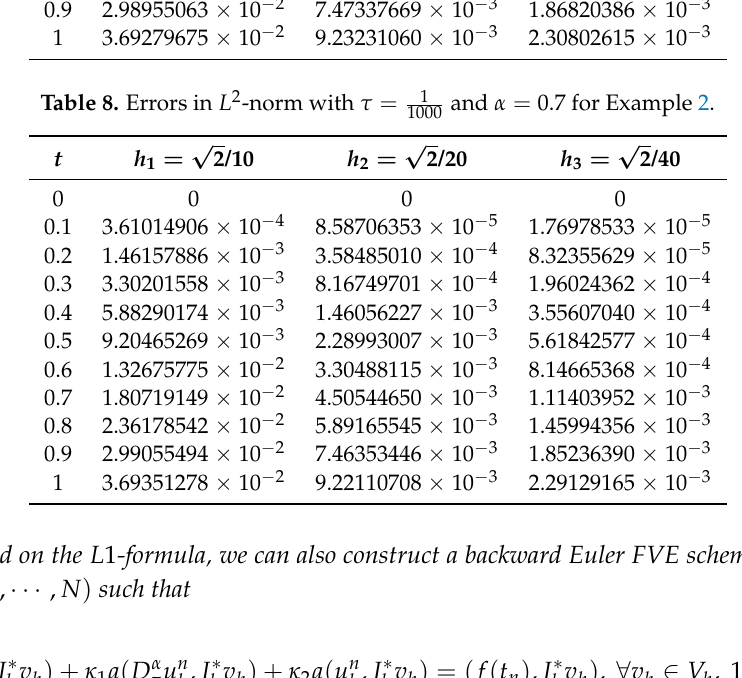
Table 8. Errors in L 2 -norm with τ = 1